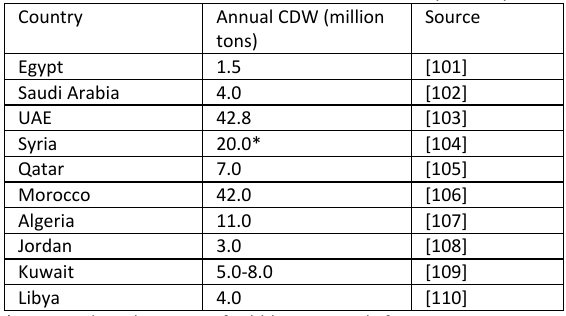
Table 3. Annual construction and demolition waste by